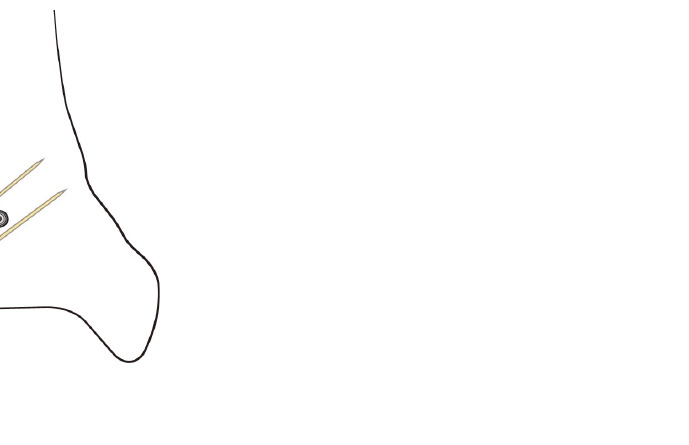
Figure 3. Stainless-steel wires are looped around the screw and the K-wires in a figure-of-eight man- ner.